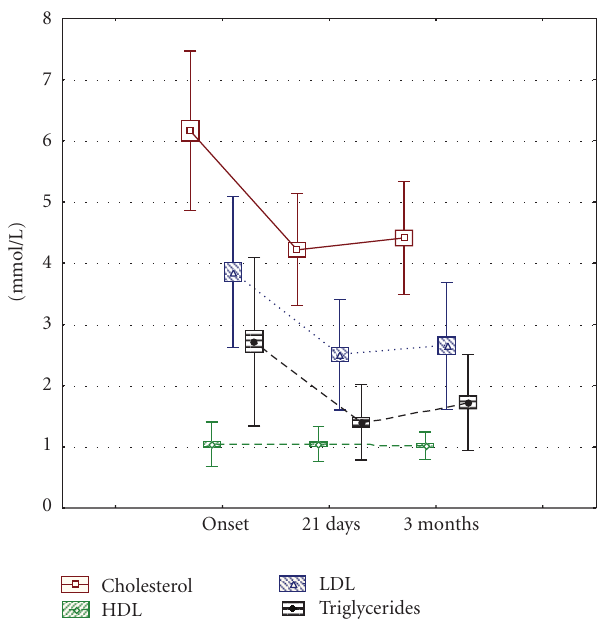
Figure 3: Evolution of the serum lipid indicators in type 2 diabetic adults with Ma-Pi 2 diet. Note: the squares represent the standard error of the mean and the mustaches the standard deviation. Values are expressed in